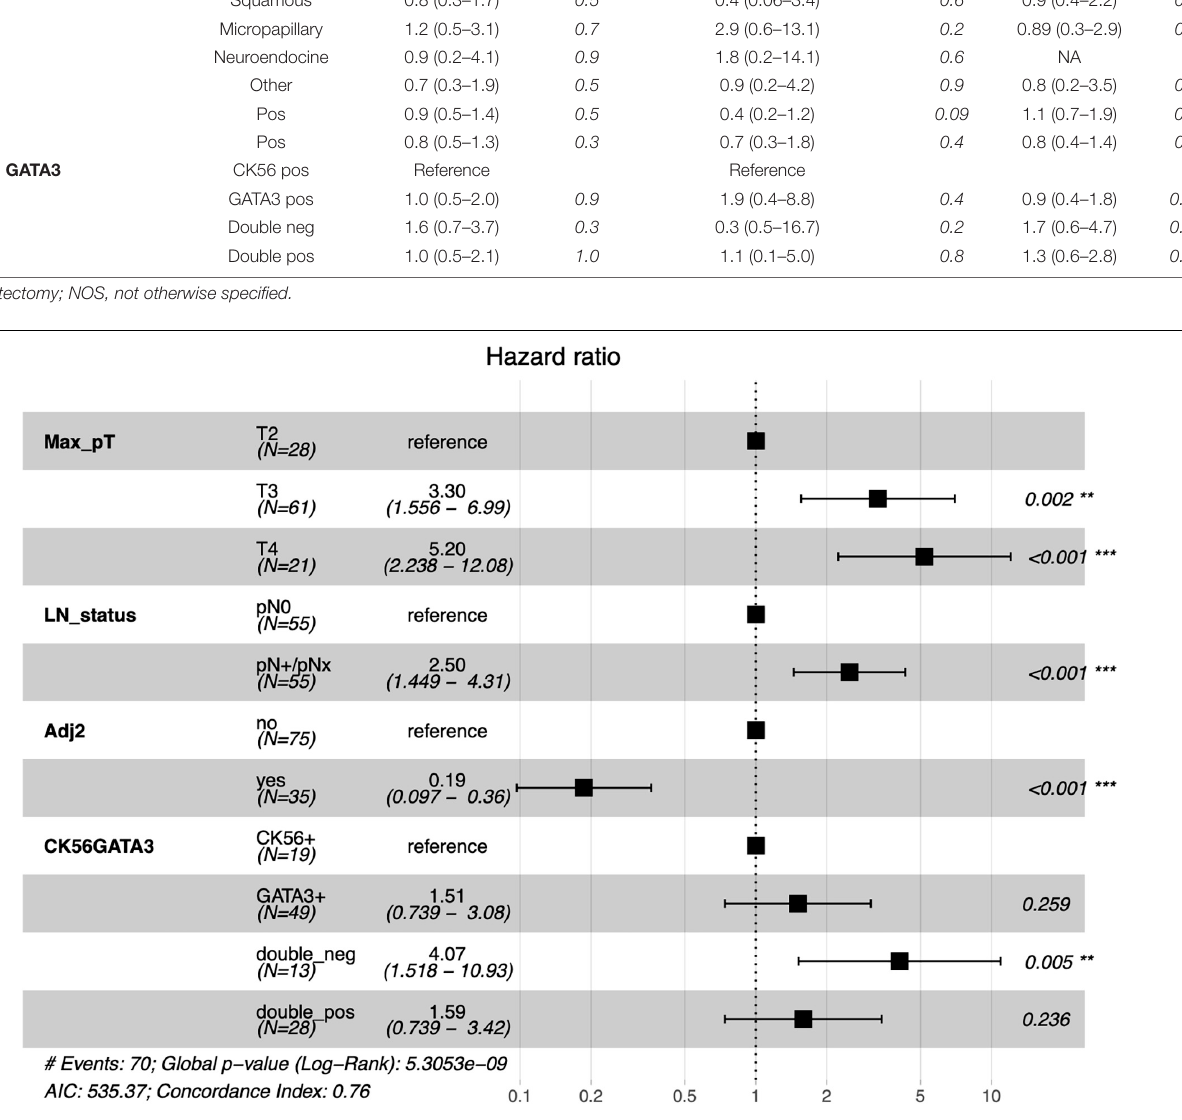
is in concordance with published data (6, 13). The